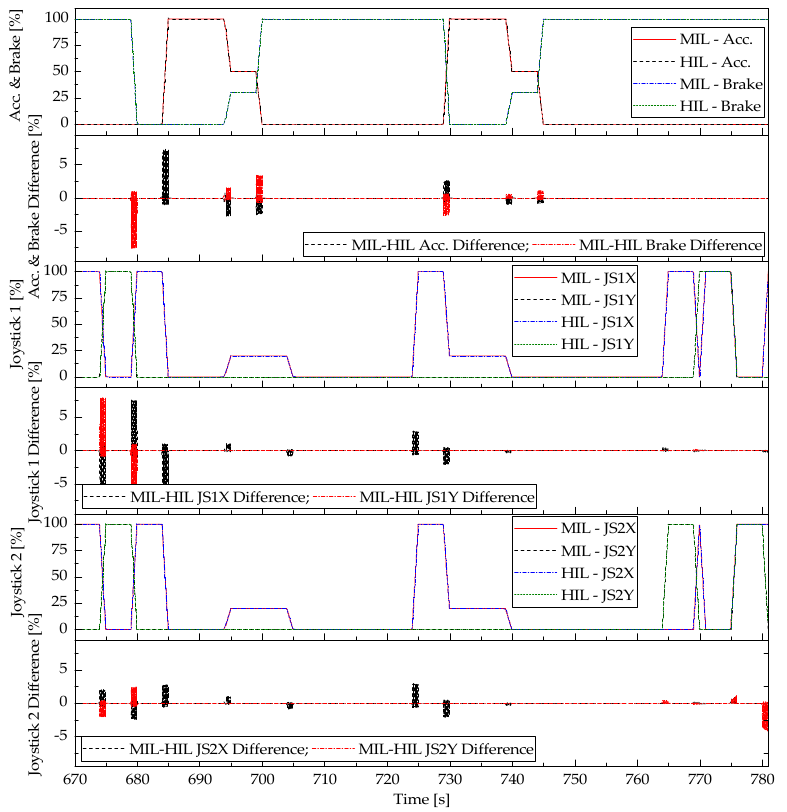
Figure 11. Comparison of HMI inputs and loads of MIL and HIL tests during cycle 7th.